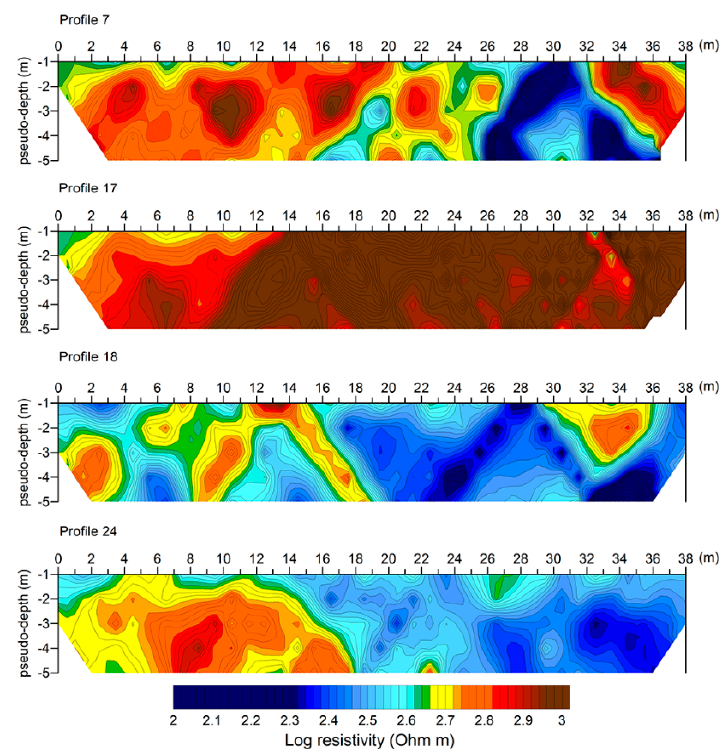
Figure 6. Geoelectrical pseudosections across profiles 07, 17, 18 and 24, drawn in Figure 4a .